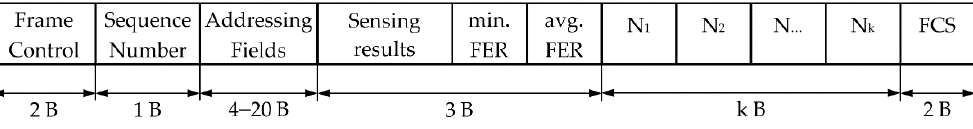
Figure 8. Hello frame format.